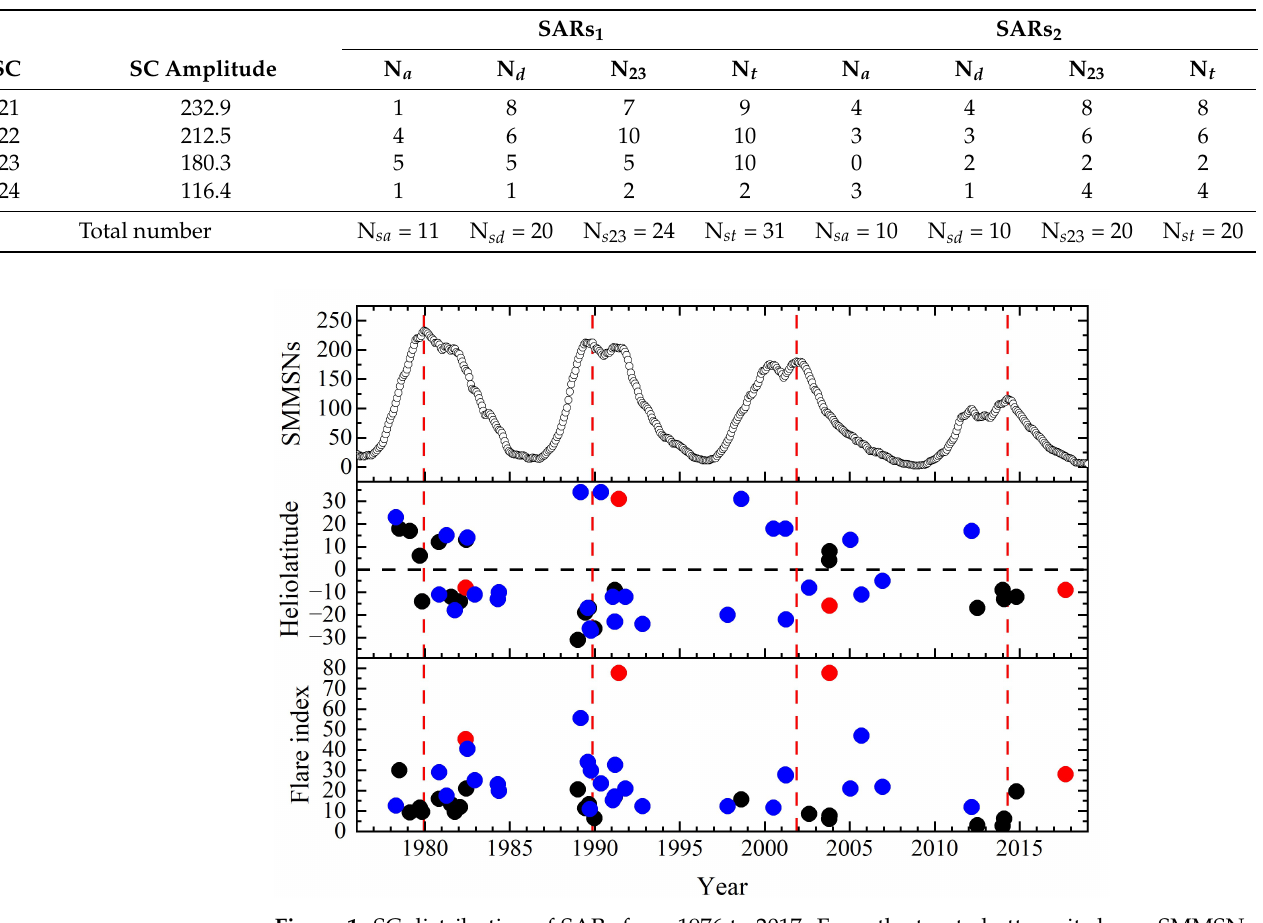
Figure 1. SC distribution of SARs from 1976 to 2017. From the top to bottom, it shows SMMSNs, the heliolatitude of the SARs, and the FI of the SARs. The black solid circles indicate the SARs 2 , whereas the blue and red solid circles indicate the SARs 1 . The red solid circles indicate the SARs that have the largest FI in each SC. The red vertical dashed lines indicate the peak times of the four SCs,